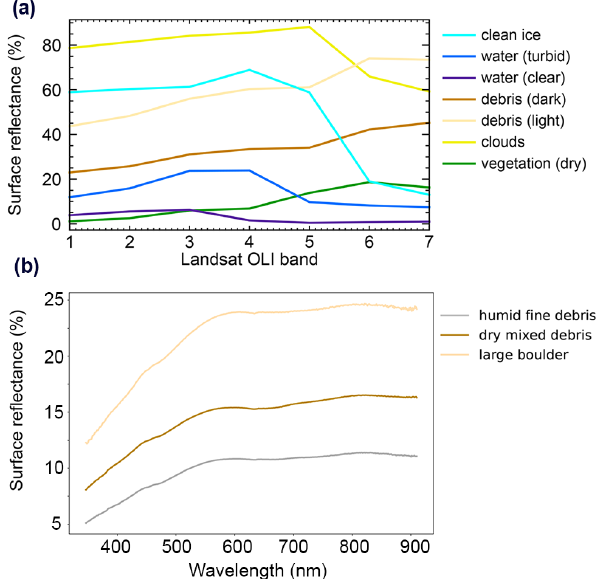
Figure 4. (a) Spectral signatures of endmembers extracted from Landsat 8 OLI bands 1 to 7 (30 September 2015 Khumbu image) after the atmospheric and topographic corrections; (b) field spec- tra from the debris-covered part of Mer de Glace Glacier (France) shown for comparison purposes